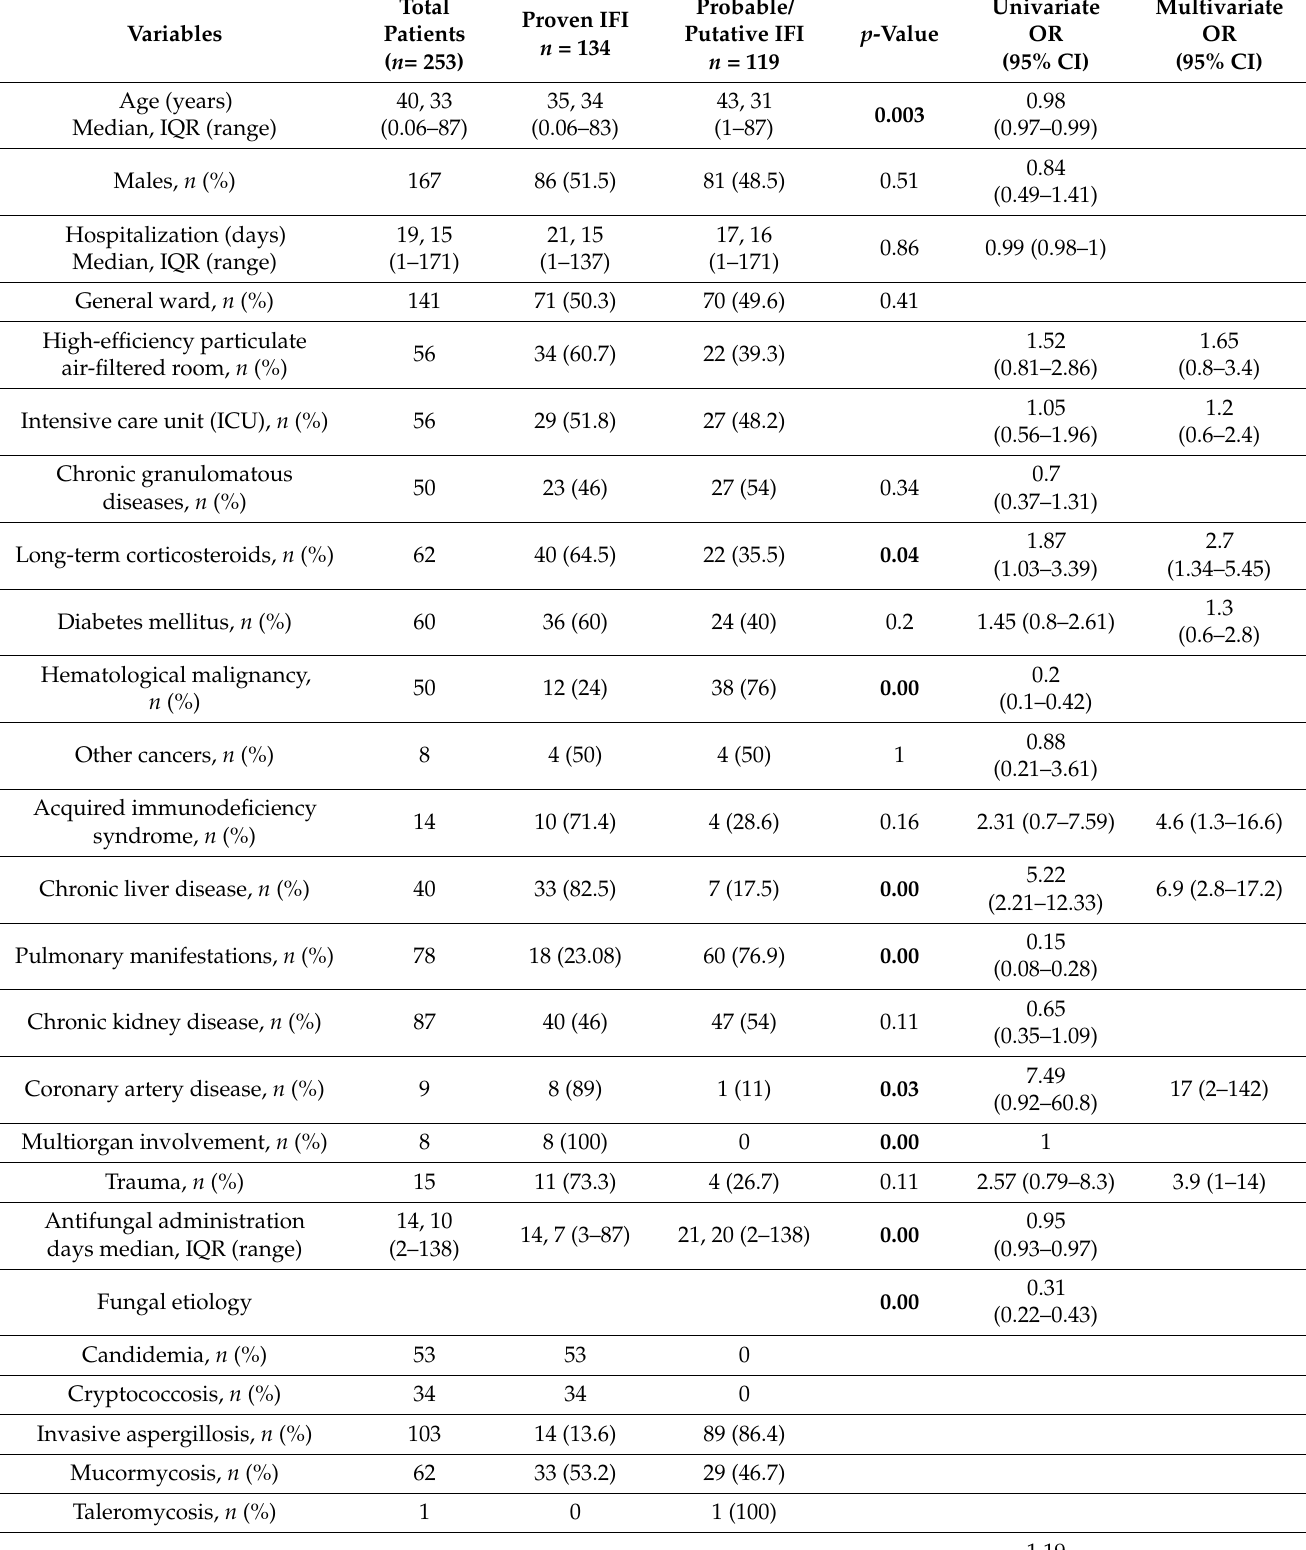
Table 2. Demographic and clinical characteristics of IFI